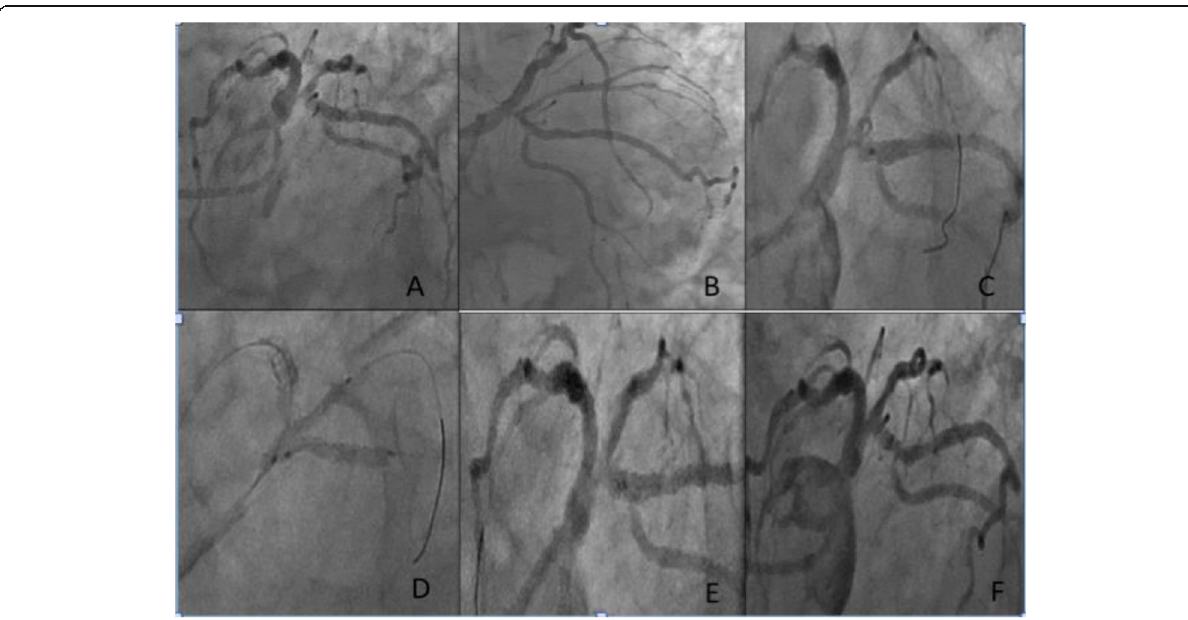
Fig. 1 a , b Bifurcation lesion involving the ostia of the LCX and RI. c After deployment of the BVS. d Kissing balloon inflation with DCB. e Final result at the index procedure. f At follow-up after 25